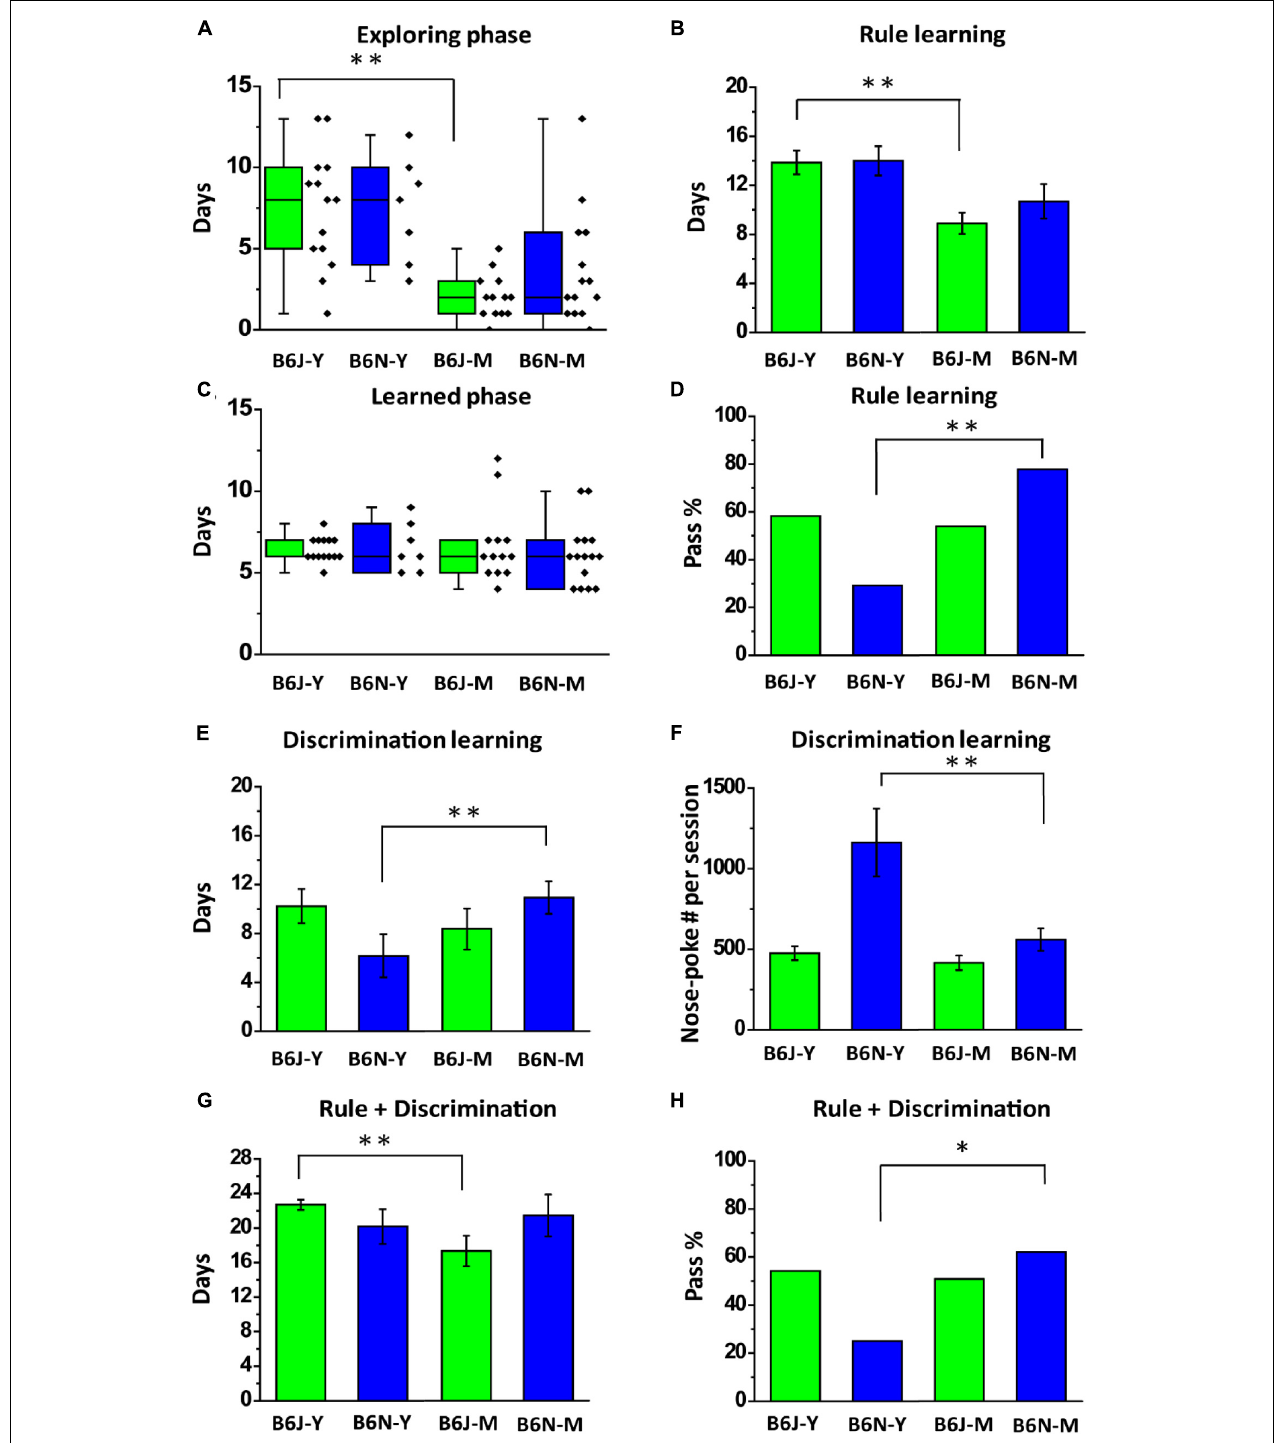
FIGURE 6 | Age-specific effects on B6J and B6N mice in different stages of olfactory two-alternative choice task. (A) Box plots of days required for the B6J and B6N mice to complete exploring phase of rule learning. (B) The numbers of days the B6J and B6N mice used to pass rule learning. (C) Box plots of days required for the B6J and B6N mice to complete learned phase of rule learning. (D) Percentages of different age groups of the B6J and B6N mice that are able to pass the stage of rule learning. (E) The numbers of days the B6J and B6N mice used to pass discrimination learning. (F) Average numbers of nose-poke in a session of the B6J and B6N mice that pass discrimination learning. (G) The numbers of days the B6J and B6N mice used to pass the whole task. (H) Pass percentages of the whole task that B6J and B6N mice at different age have. ∗ p < 0.05. ∗∗ p < 0.01.